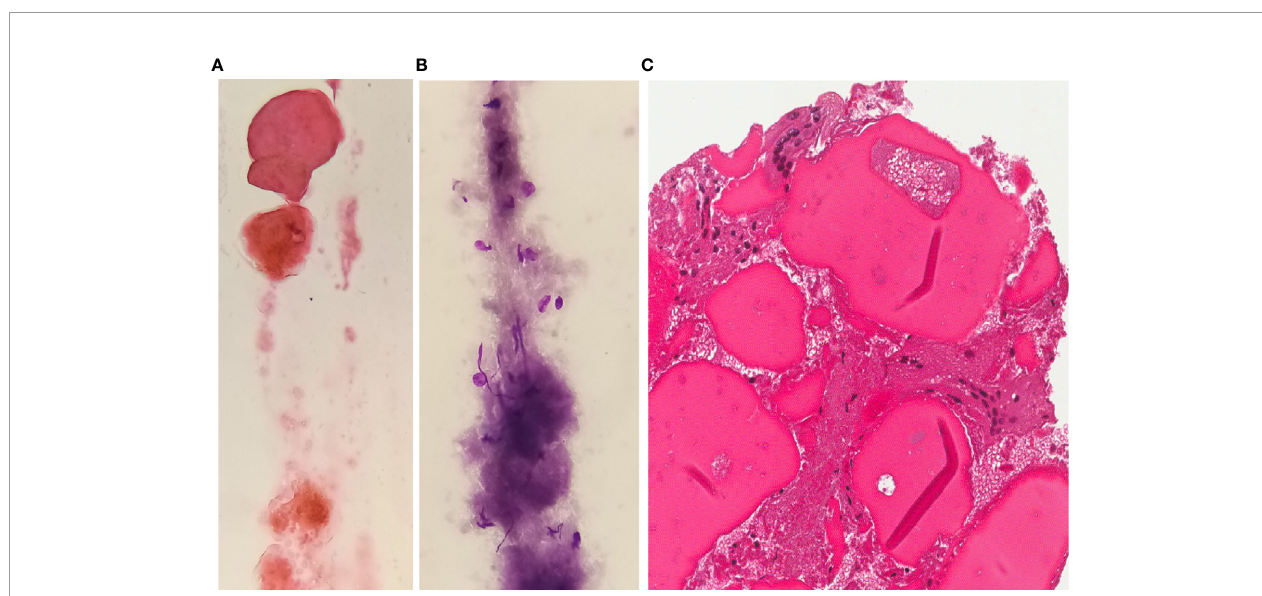
FIGURE 3 | FNAC after RFA H&E (A) or Giemsa (B) stained smears and H&E stained section from cell-block (C) exhibit a poorly cellular sample with sparse in fl ammatory elements or multinucleated giant cells in a background of thick colloid and fi brosis (magni fi cation